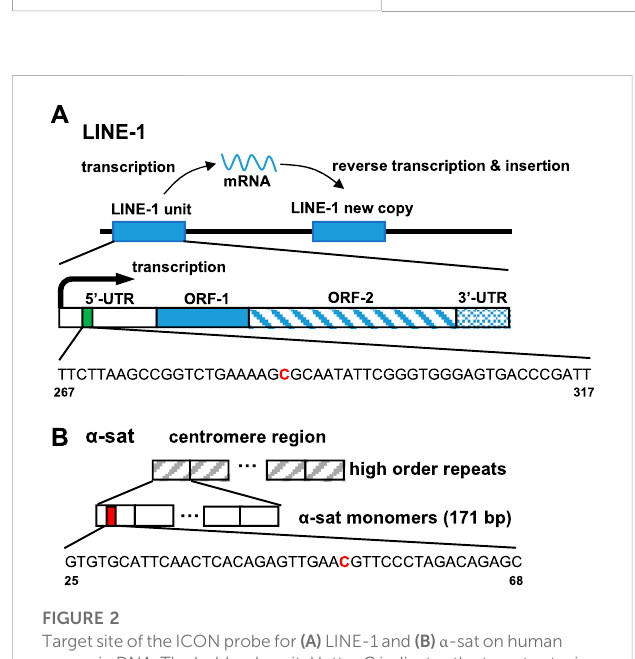
FIGURE 2 TargetsiteoftheICONprobefor (A) LINE-1and (B) α -satonhuman genomic DNA. The bold red capital letterC indicates thetargetcytosine.